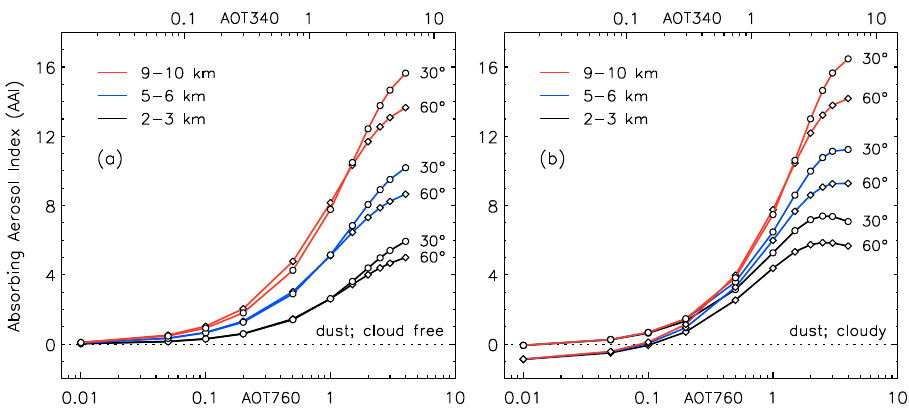
Fig. 8. Simulations of the absorbing aerosol index for dust aerosols as a function of aerosol optical thickness in (a) cloud free scene and (b) cloudy scene. The scenes are the same as in Figs. 5–7. Results for two solar zenith angles are plotted, 60 ◦ and 30 ◦ . Viewing direction is